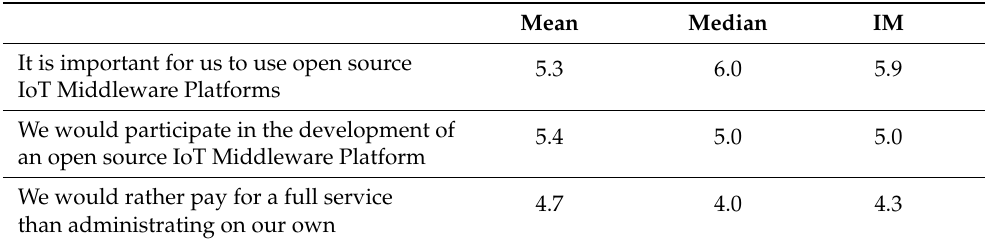
Figure 4. Responses to survey questions show how important are the IoT platforms for different categories of users. Table 1. Means, medians and interpolated medians of answers to questions prefaced by: To what extent do you agree with the following